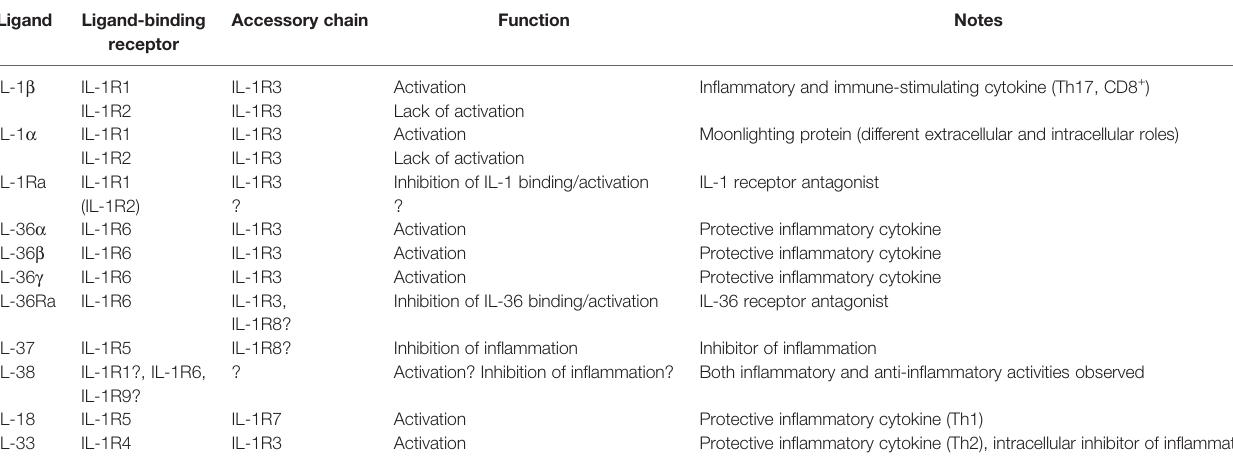
TABLE 2 | The IL-1 superfamily and the family of IL-1R*. Ligand Ligand-binding Accessory receptor